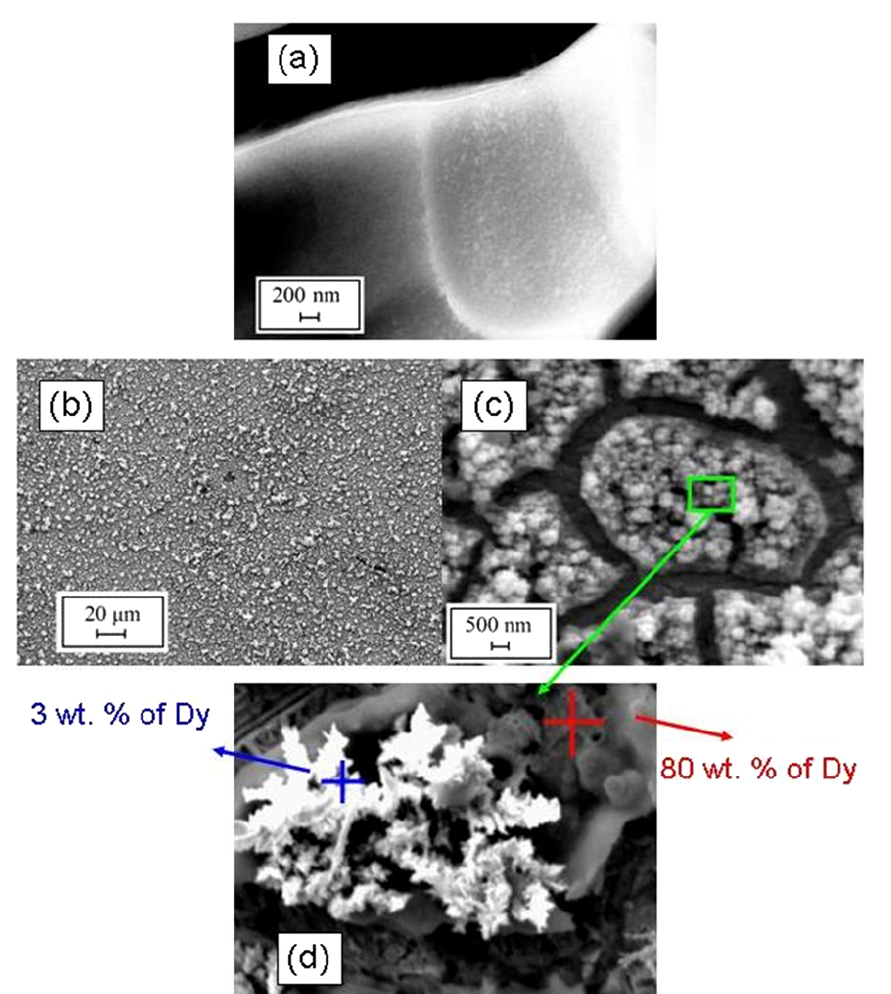
Figure 2. SEM micrographs of Au-Dy electrochemically grown film at the potential of − 1.8 V for 2 hour, before ( a ) and after ( b , c and d ) heat treatment at 650 °C for 1